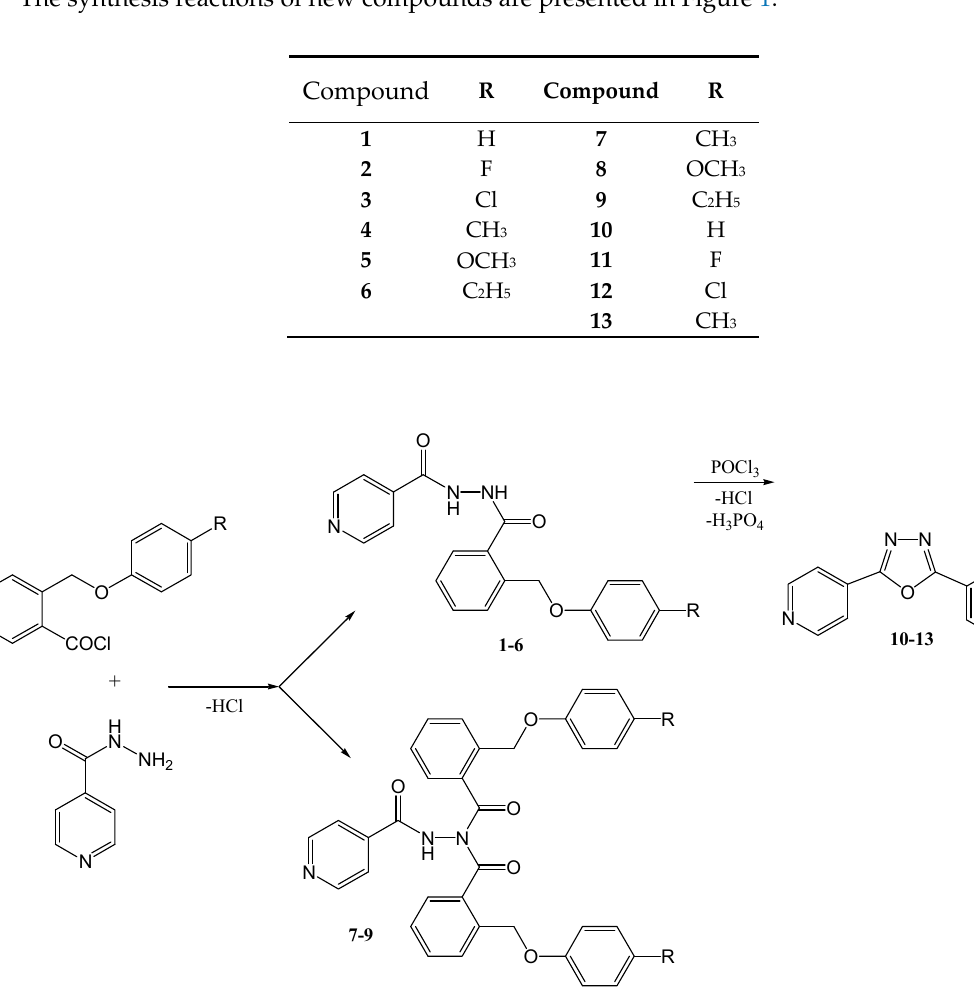
Figure 1. Synthesis of the new isoniazid derivatives.